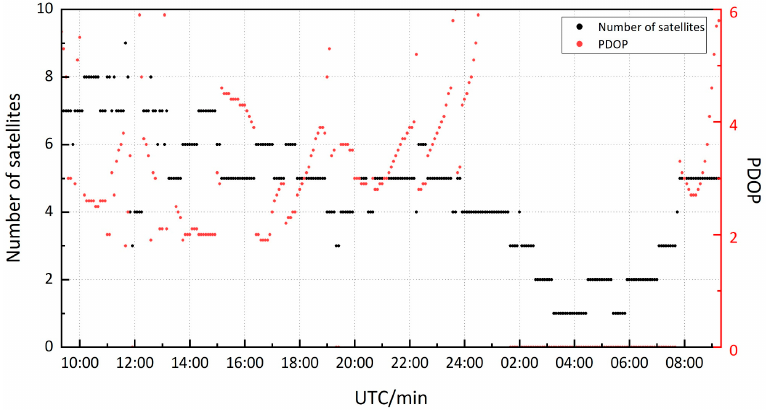
Figure 4. The number of satellites with simultaneous L1 and L5 frequency data record and PDOP.